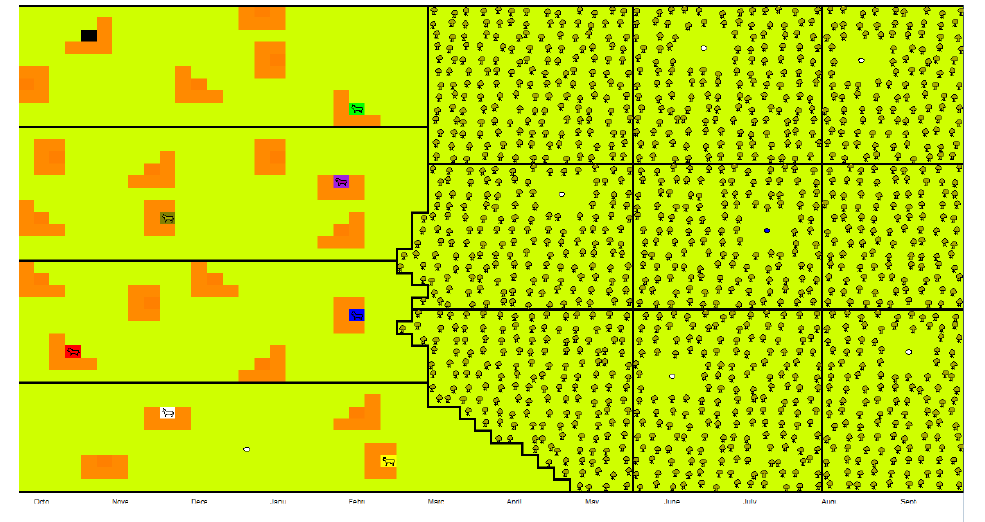
Figure 6. The virtual environment at the initiation of the model/playing